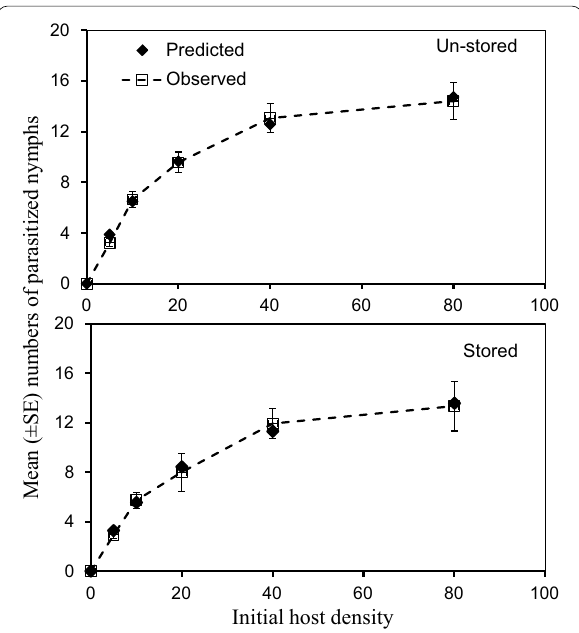
Fig. 4 Functional response curves of Eretmocerus mundus adults obtained from unstored and eight-day-stored pupae to the different 2nd instar nymph densities of Bemisia